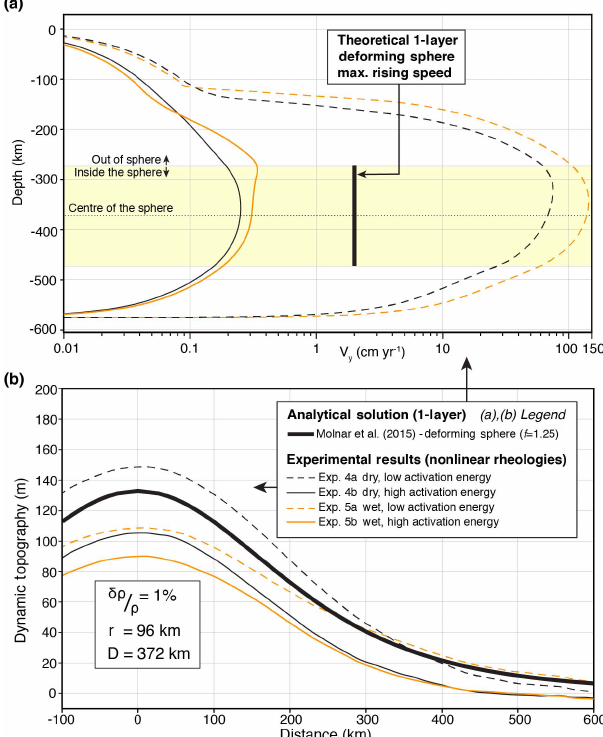
Figure 6. (a) Vertical velocity profiles ( V y ) along the centre and (b) dynamic topography induced by a sphere of temperature anomaly ( r = 96km, δρ/ρ = 1%) in the mantle that has nonlinear rheology depending on temperature, pressure and strain